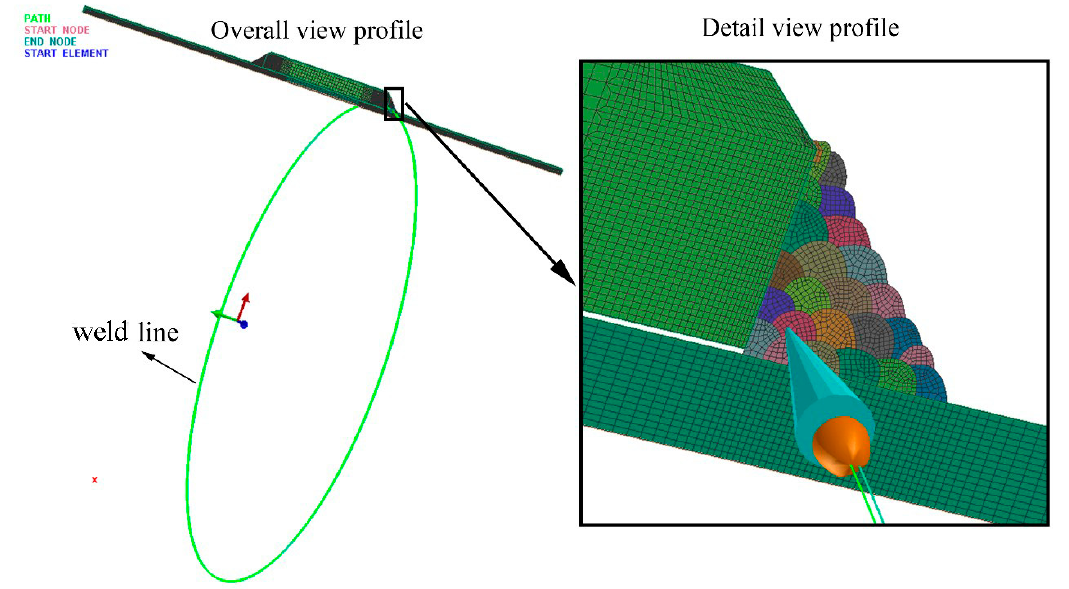
Figure 6. Schematic diagram of the 2D rotational model.